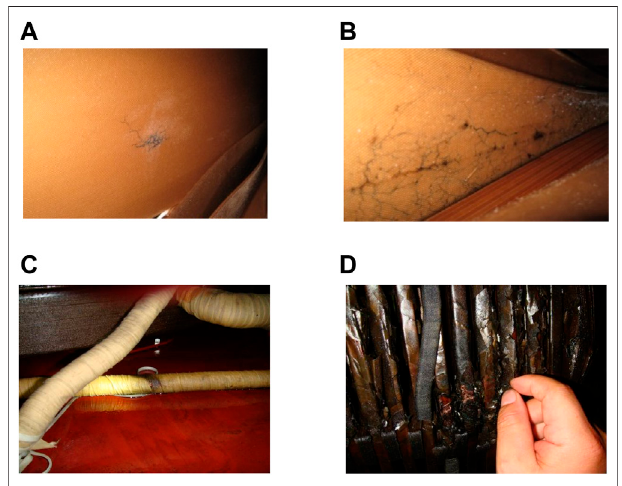
FIGURE 1 | Insulation discharge phenomena of transformers. (A) Insulation paperboard at the outer enclosure of transformer (B) Insulation